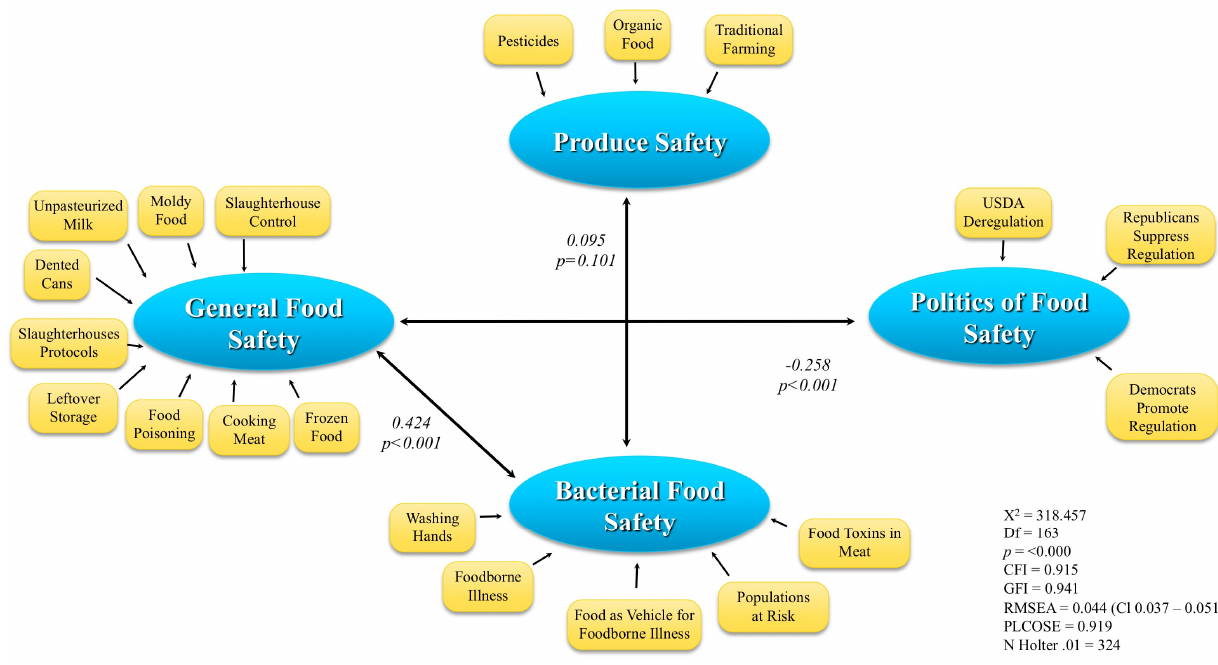
Figure 6. Structural Equation